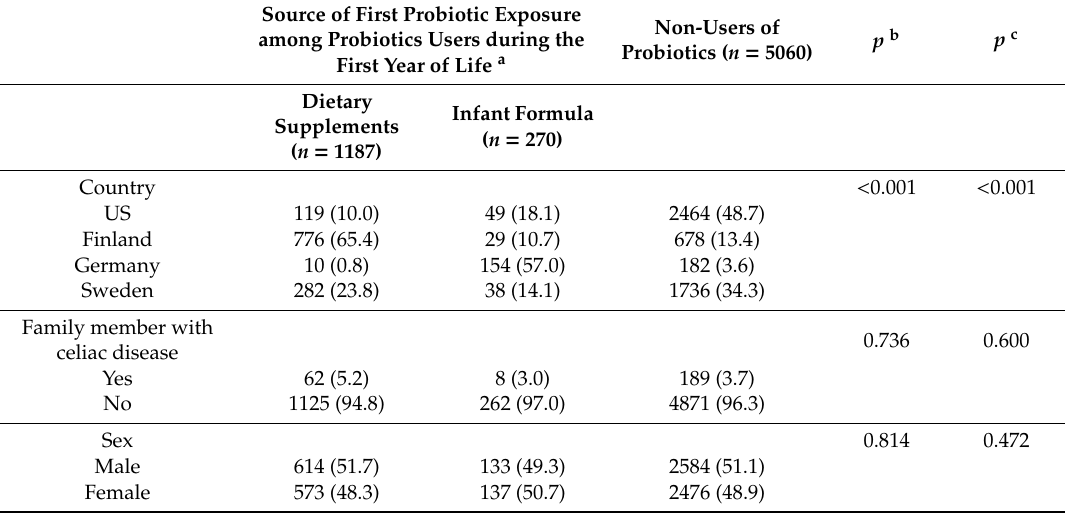
Table 2. Characteristics of probiotics users by source of first exposure and non-users during the first year of